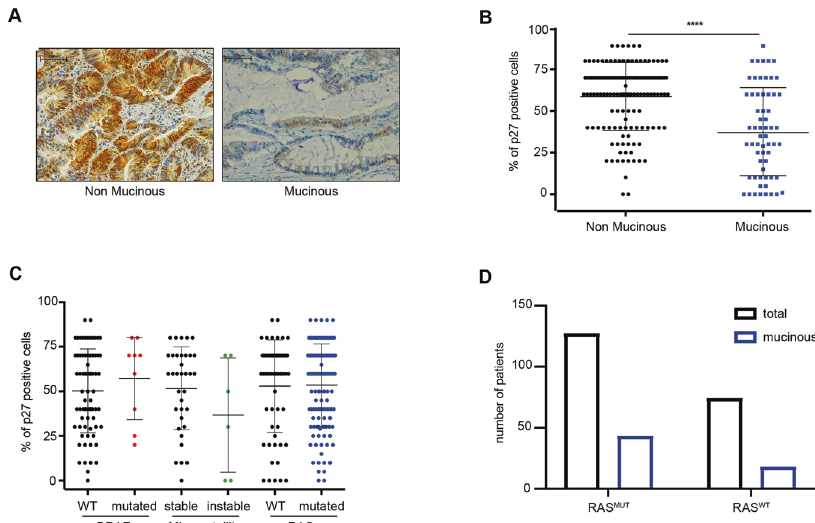
Fig. 1 Expression of p27 is independent from most clinical and molecular parameters in colorectal cancer (CRC). A Immunohistochemistry (IHC) analysis of p27 expression in non mucinous (left) and mucinous (right) CRC (20x magni fi cation). B Percentage of p27 positive cells in non mucinous and mucinous CRC samples. In B and C, each dot corresponds to a CRC sample. Mann – Whitney test was used for statistical analysis (**** p < 0.0001). C Percentage of p27 positive tumor cells classifying CRC samples with different molecular features, as indicated. D Graph reports the number of all analyzed tumors (black) and tumors with mucinous features (blue), with respect to their RAS mutational